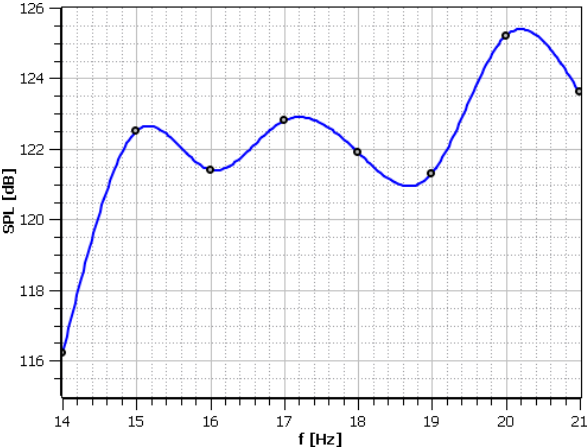
Figure 11: Minimum sound pressure causing extinguishing effect in the function of sound